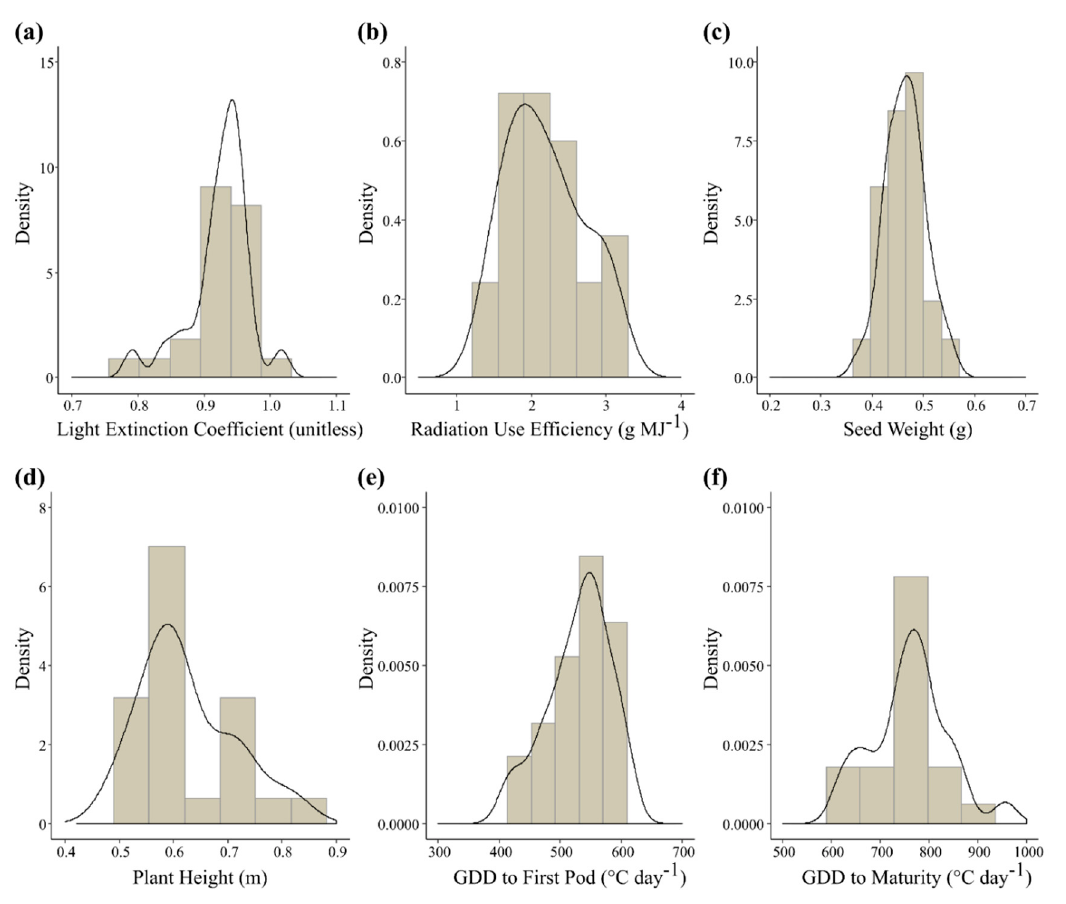
Figure 4. Variability observed among the 24 bean cultivars for the six functional traits considered: light extinction coefficient ( a ), radiation use efficiency ( b ), seed weight ( c ), plant height ( d ), thermal time to first pod ( e ), thermal time to maturity ( f ). See Table 1 for the Shapiro–Wilk normality test statistics.